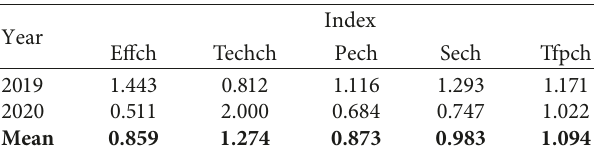
Table 4: Calculation results of innovation performance